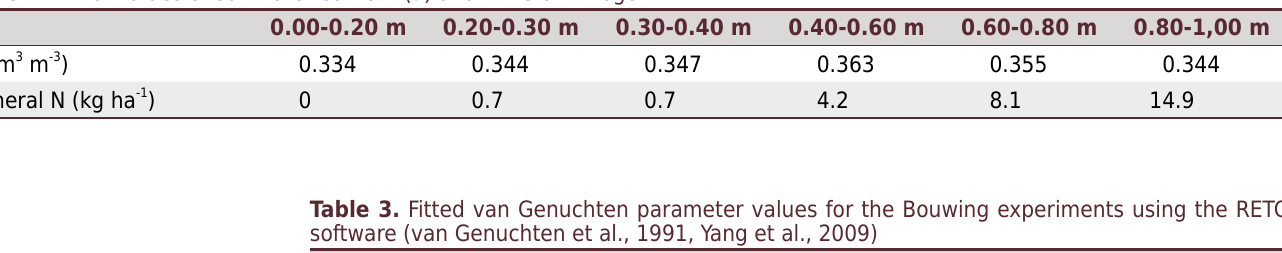
Table 3. Fitted van Genuchten parameter values for the Bouwing experiments using the RETC software (van Genuchten et al., 1991, Yang et al., 2009)